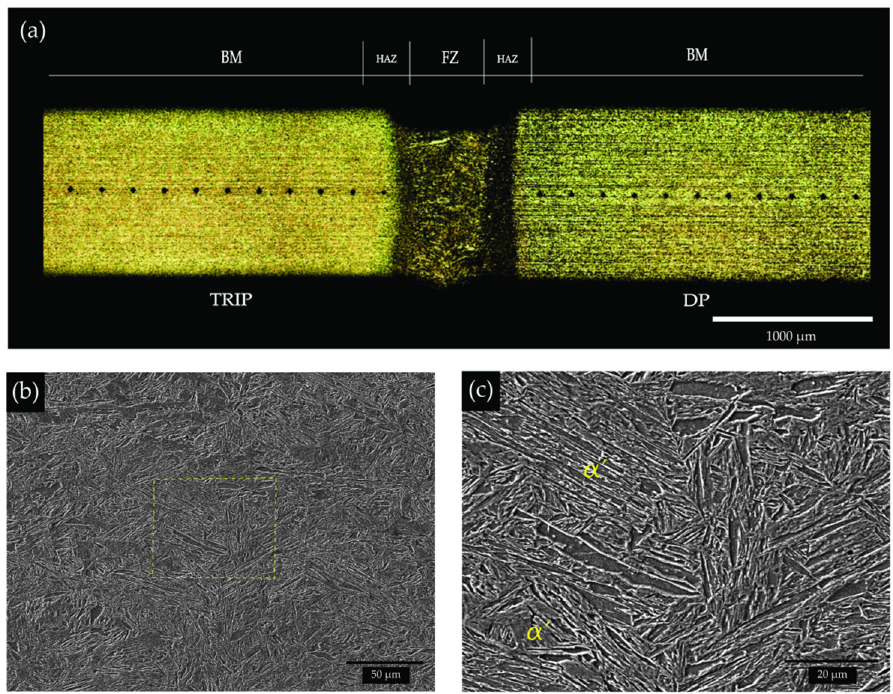
Figure 7. ( a ) Macrostructure of the LBW specimen showing the various zones along the weldment,